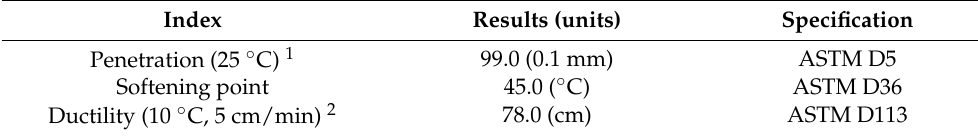
Table 2. The physical and mechanical properties of base asphalt.